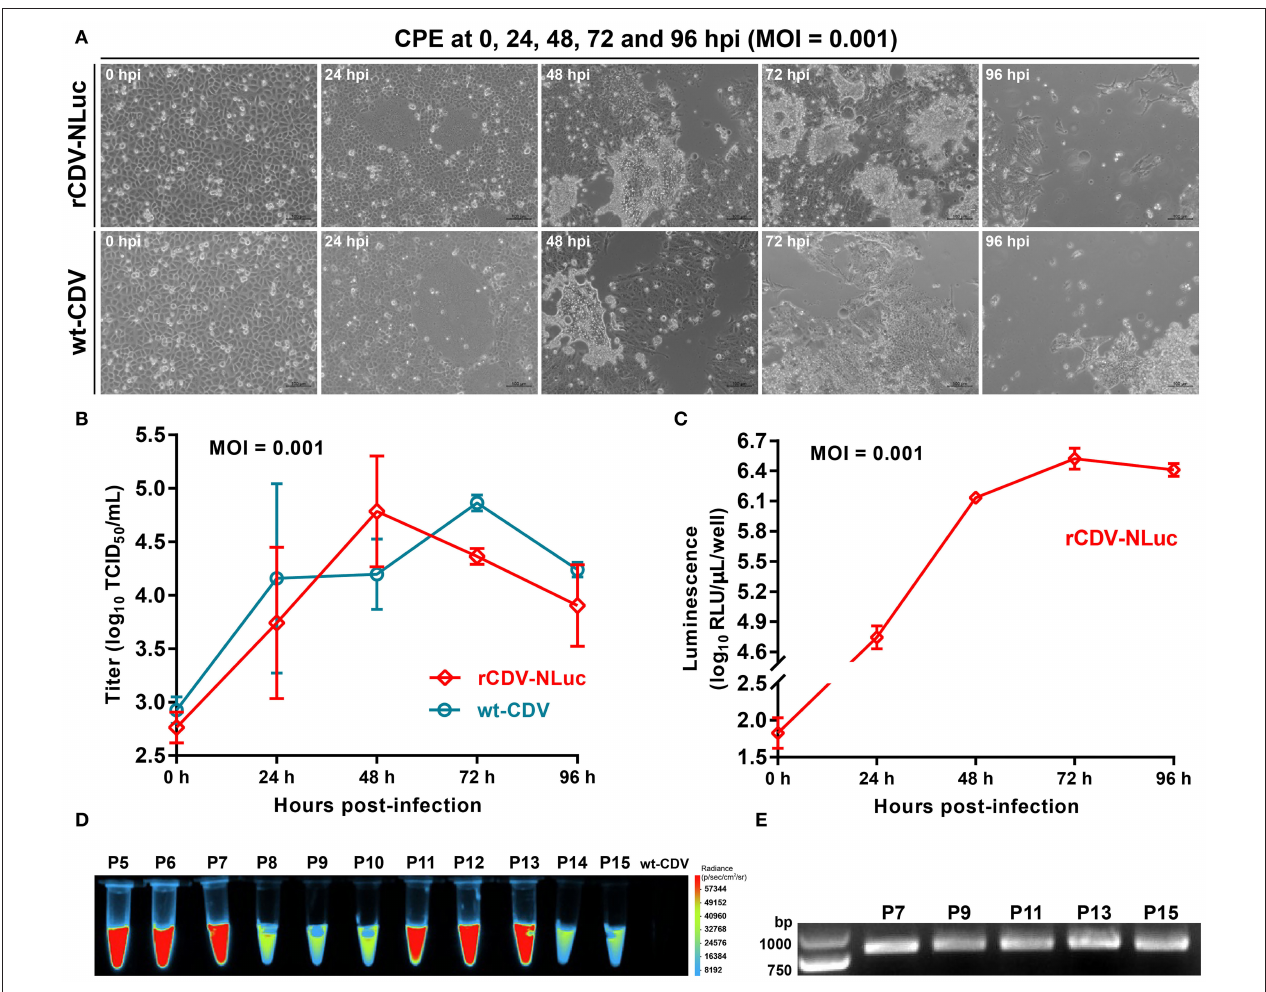
FIGURE 2 | Characterization of the rCDV-NLuc. CPEs on VDS cell monolayers infected (MOI = 0.001) either with the P7 rCDV-NLuc or with the wt-CDV at 0, 24, 48, 72, and 96 hpi (A) . Multi-step growth curves of the P7 rCDV-NLuc and the wt-CDV in VDS cells during 96 hpi (B) . Kinetics of NLuc expression by the rCDV-NLuc in VDS cells during 96 hpi (C) . RLU: relative luminescence unit. Luminescence assay on genetic stability of the NLuc during serial virus passages in VDS cells (D) . RT-PCR analyses of the P7, P9, P11, P13, and P15 rCDV-NLucs using the FP/RP primers (E)